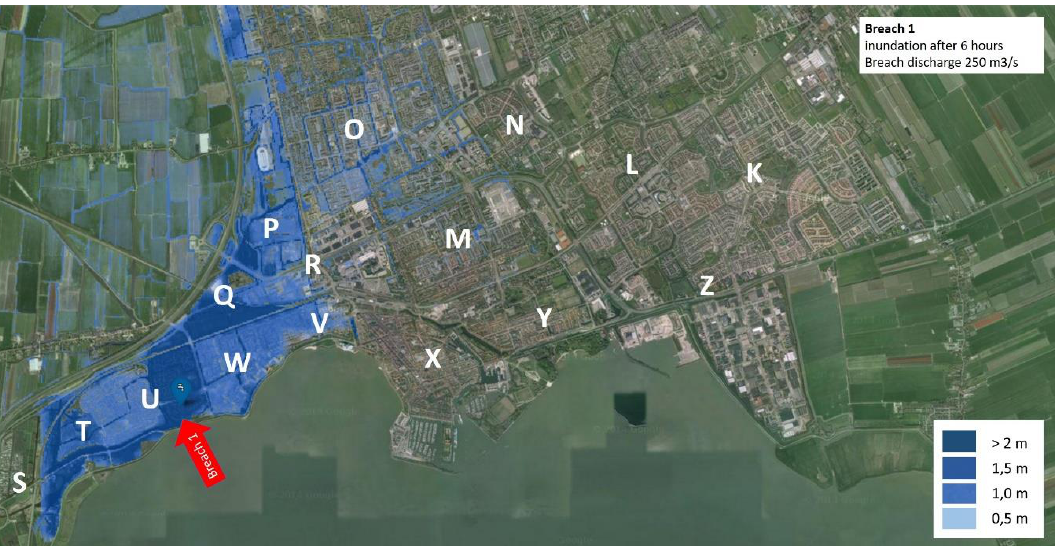
Figure 3. One of the six flood maps showing the flooded area after six hours at several dam breach locations. The neighborhoods are indicated with letters for orientation purposes. The flood maps where created with the same model as the one that was used interactively.